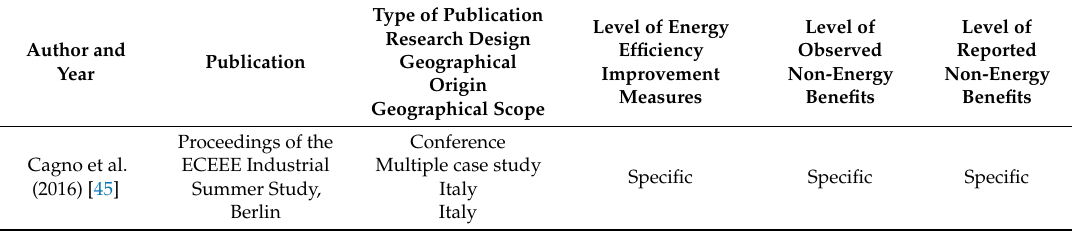
Table A1. A compilation of the descriptive analyses of the articles included in the systematic literature review on methods for studying the non-energy benefits of industrial energy efficiency